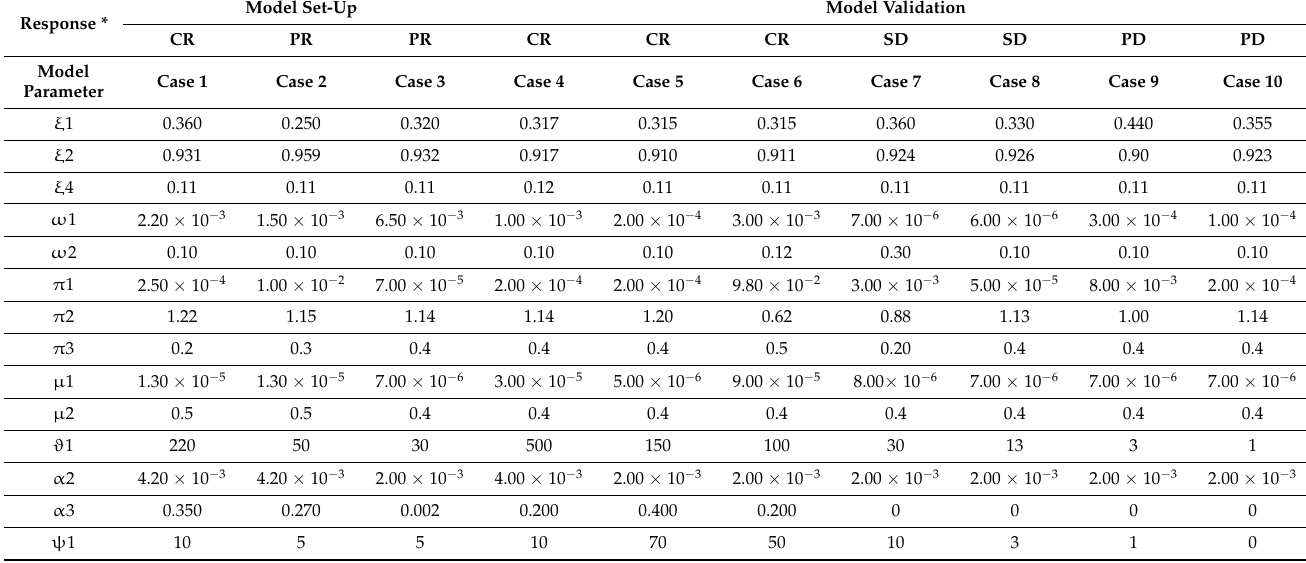
Table 2. Model parameters computed by best fitting of AFP and PIVKA-II levels in all